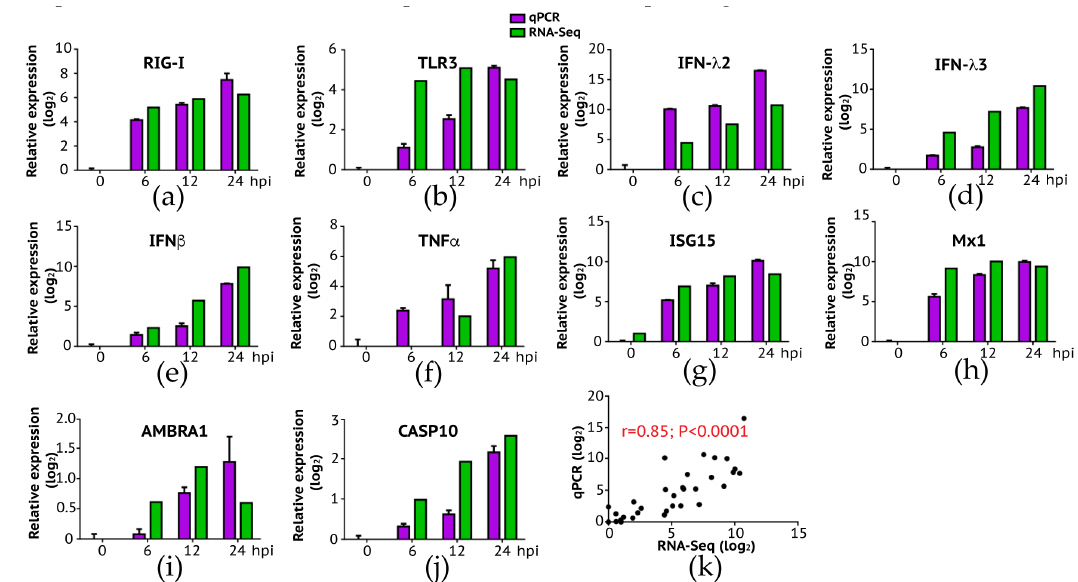
Figure 4. Expression levels of host genes in A549 cells verified using RT-qPCR. To validate the expression results observed in NGS, we selected a group of differentially expressed genes and performed qPCR. Overall, consistent with RNA-Seq analysis, the expression fold change of genes in innate